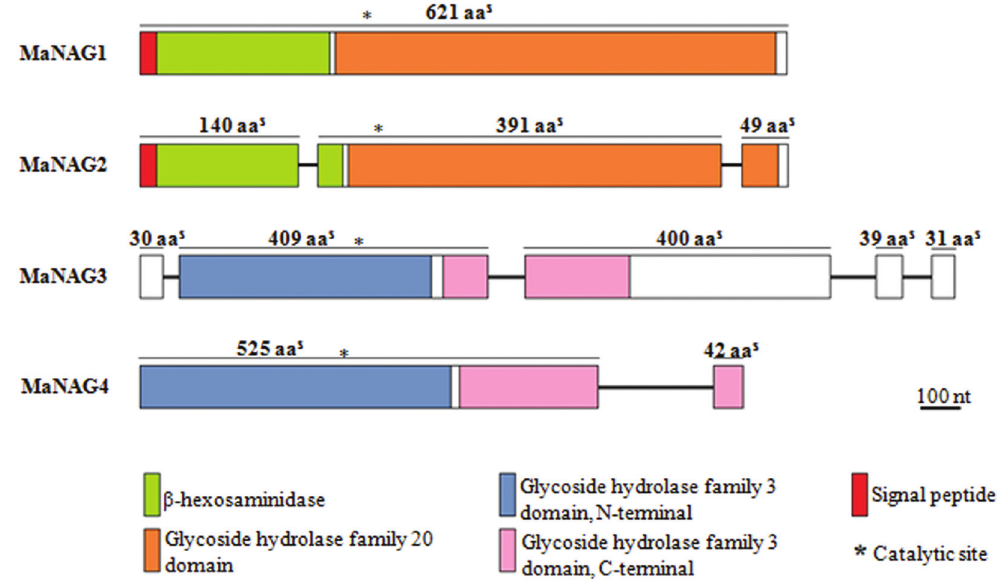
Figure 1 - Modular domain structure from M. anisopliae NAGase genes. NAGase genes exhibit specific conserved domains with different compositions. Coding exonic sequences are depicted as boxes (color codes are indicated) and introns as thin lines. Domains were identified using Conserved Database Domain (at NCBI), dbCAN and InterProScan. Signal peptide sequences were predicted using SignalP 4.1. Blank protein regions indicate the absence of characterized